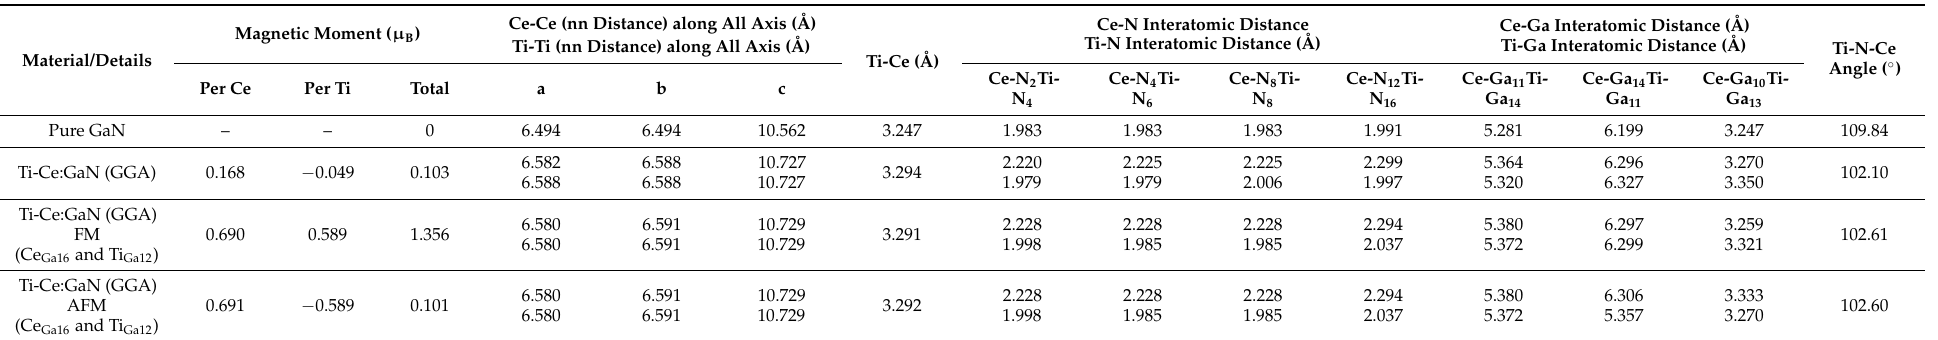
Table 6. The values of magnetic moment, and structural parameters computed for pure GaN, and Ti-Ce:GaN without and with Hubbard correction for FM and AFM configurations. The values of Ce-Ce and Ti-Ti nearest neighbor separation in a, b and c-axis are given. The dopant sites in the host were switched as per given